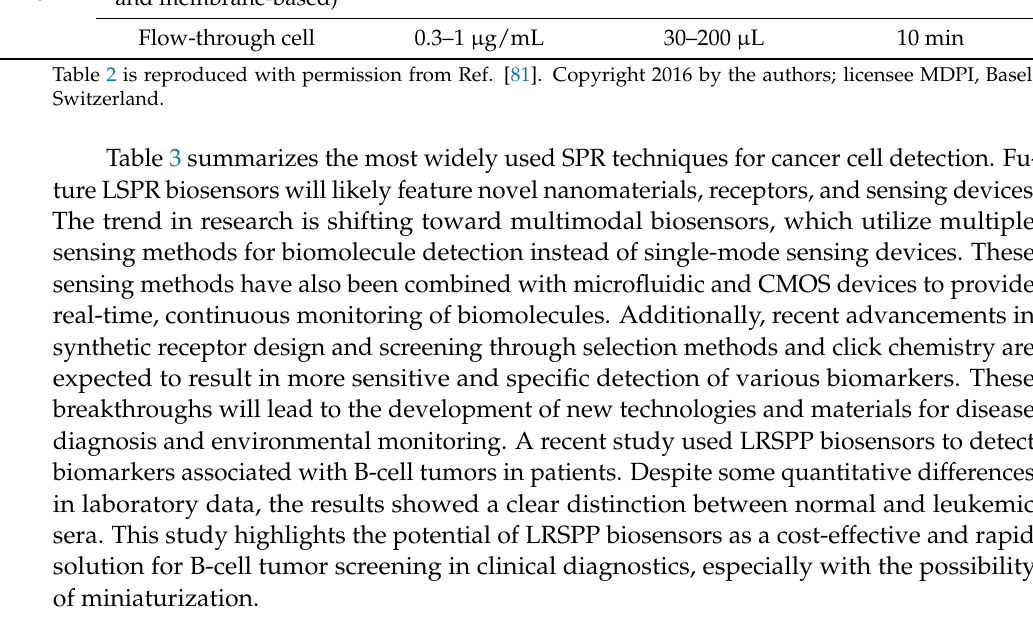
Table 2 is reproduced with permission from Ref. [81]. Copyright 2016 by the authors; licensee MDPI, Basel, Switzerland. Table 3 summarizes the most widely used SPR techniques for cancer cell detection.